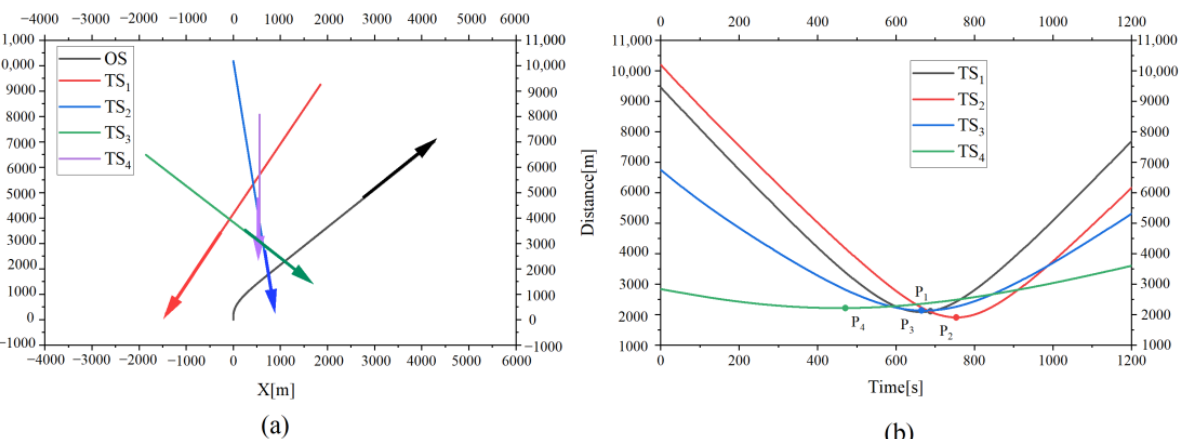
Figure 15. Simulation results of scenario 2: ( a ) Trajectory of OS and TSs; ( b ) Distance between OS and different TSs; ( c ) DCPA between OS and different TSs; ( d ) Speed of OS. 5. Analysis and Discussion 5.1. Results and Discussion The core algorithm for avoiding collisions, which combines the improved MMG and VO algorithms, was proposed in the preceding section. Two groups of case studies are of- fered to demonstrate the effectiveness of the basic algorithm in various encounter circum- stances in this paper. The results and discussion are as follows. In the situation of a multi-vessel encounter, the ship ’ s avoidance action should not only evaluate the vessels with whom the ship is at risk of collision with, but should also take into account whether this action will generate a new danger of collision with other TS. In Sce- nario 1, the action taken by OS to avoid collision with TS 1 , TS 2 , and TS 3 , will impede the safe movement of TS 4 ; In Scenario 2, when taking measures to present the TS in danger, the ships must take into account the TS 3 , although the risk of collision does not exist. In some circumstances, changing speed can successfully lessen the amplitude of the alternation of course, which is highly advantageous for confined seas. In Scenario 1, only three decisions by altering course to the starboard side to avoid collision for all the TSs, and the minimum degree (41°) in the manner of only altering course are greater than the minimum degree (37°) in the manner of both alterations of course and speed. However, in Scenario 2, only altering course is the optimal decision for collision avoidance. Thus, alternation of speed is a benefit for collision avoidance in some special circumstances. The dynamic feasible manoeuvring interval is shown in Figure 12 The outcome demonstrates that decision-making at distinct telegraphs may be used to avoid collision in common scenarios. The evaluation function is used to determine the optimal decision based on timeliness and economy. From Figures 13b and 15b, the relative distance be- tween OS and TS shows that TS is not invaded its ship domain. In all case investigations, the minimum distance between OS and TS at various deci- sion-making points is more than 2(𝐿 1 + 𝐿 2 ) , indicating that TS does not invade OSs ship domain. Furthermore, the resulting DCPA is significantly bigger than the safety